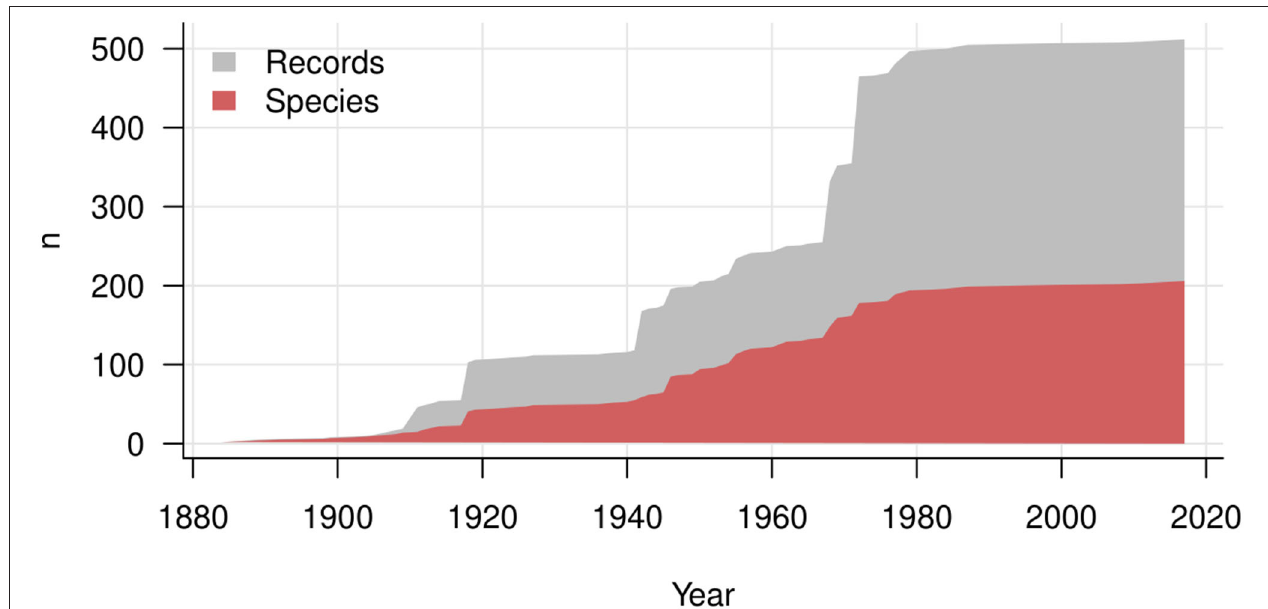
FIGURE 7 | History of description of hyperparasitic fungi on Meliolales over years. The gray area shows the increasing number of records, and the red area the cumulative number of species and infraspecific taxa.